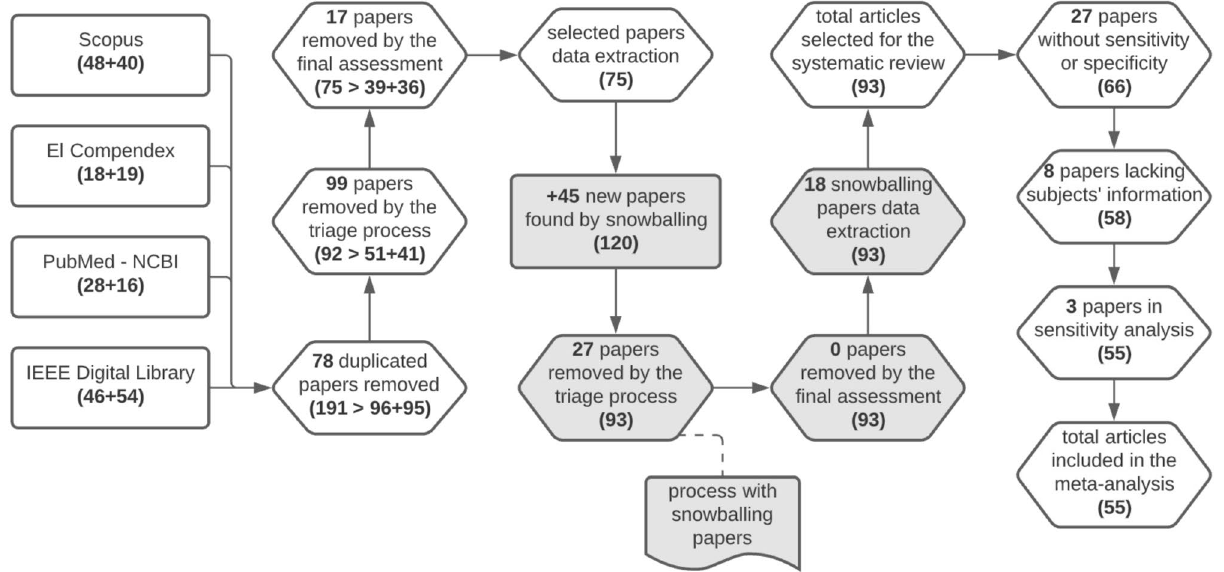
Figure 1. Screening and selection of studies according to inclusion and exclusion criteria at different stages of the meta-analysis. The numbers between parentheses indicate the total of articles remaining after each step. The numbers separated by + indicate the count of articles from the first and second search, respectively. Created with Lucidchart Free https:// www. lucid chart. com.